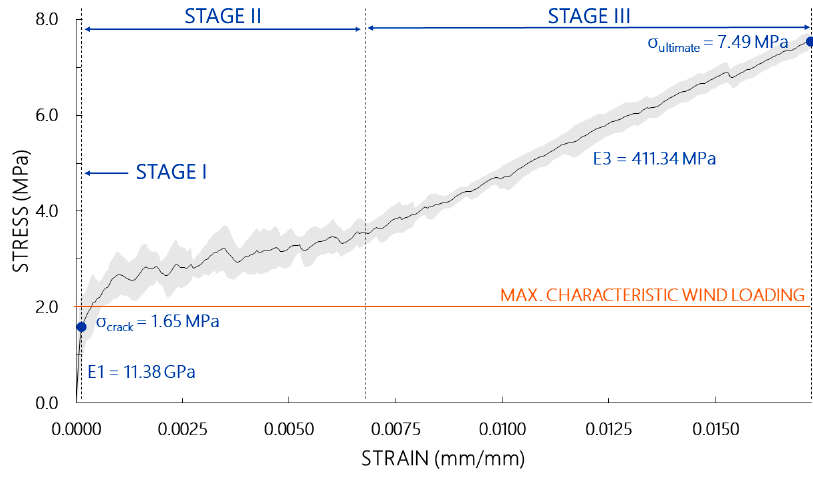
Figure 7. Reference behavior of TRC coupons.